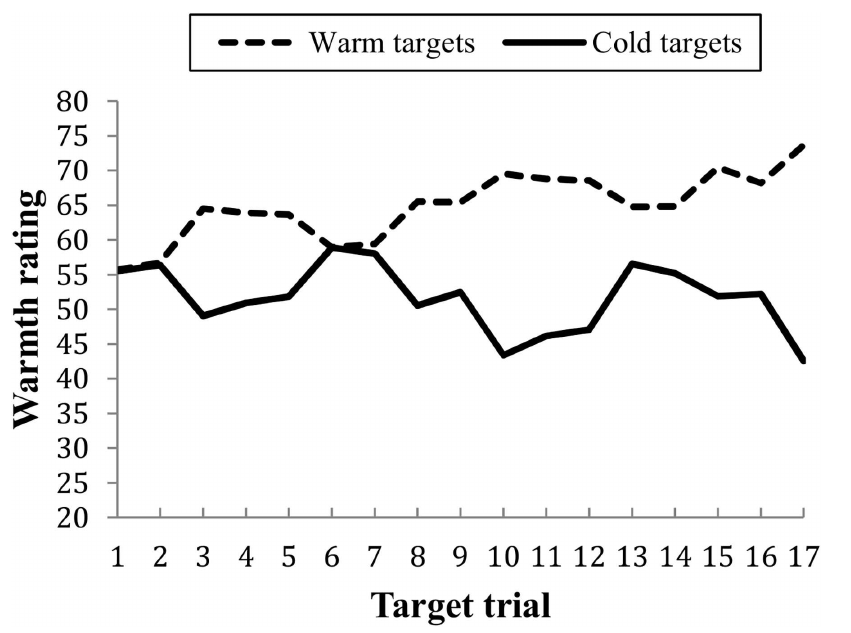
Fig 5. Warmth ratings across the 17 trials for mainly warm and mainly cold targets.